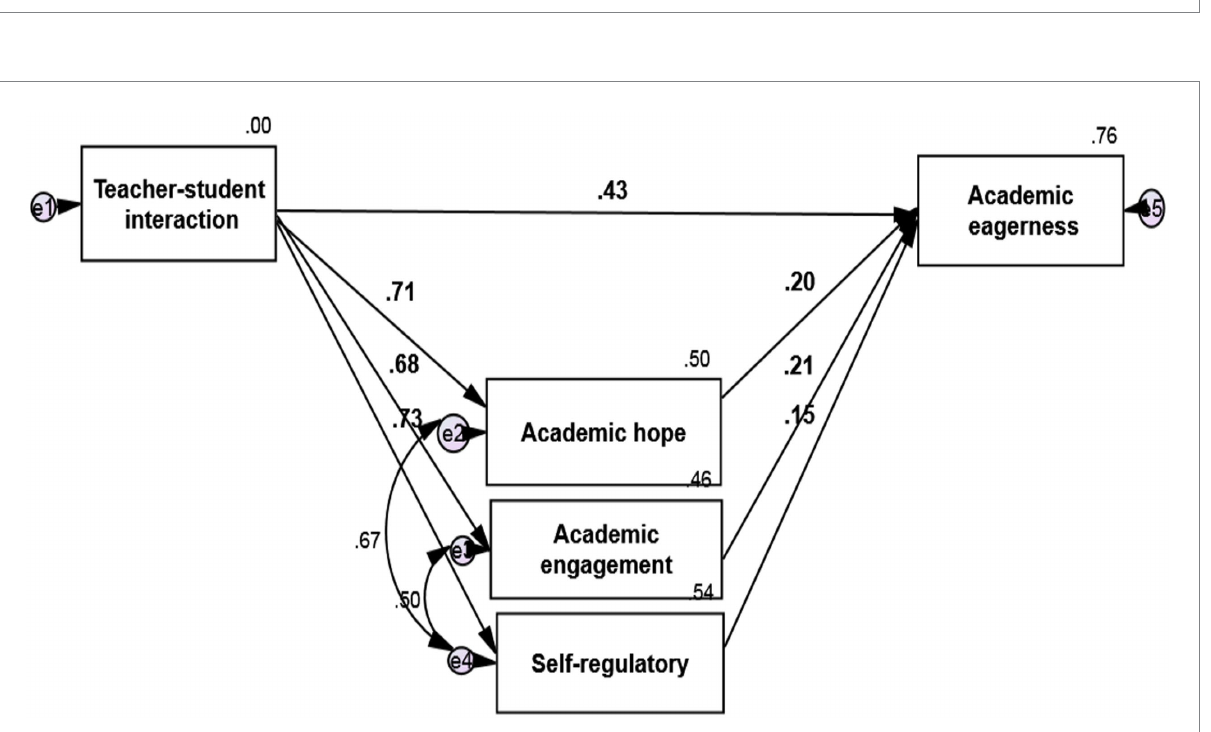
FIGURE 2 Model fit in standard estimation mode.